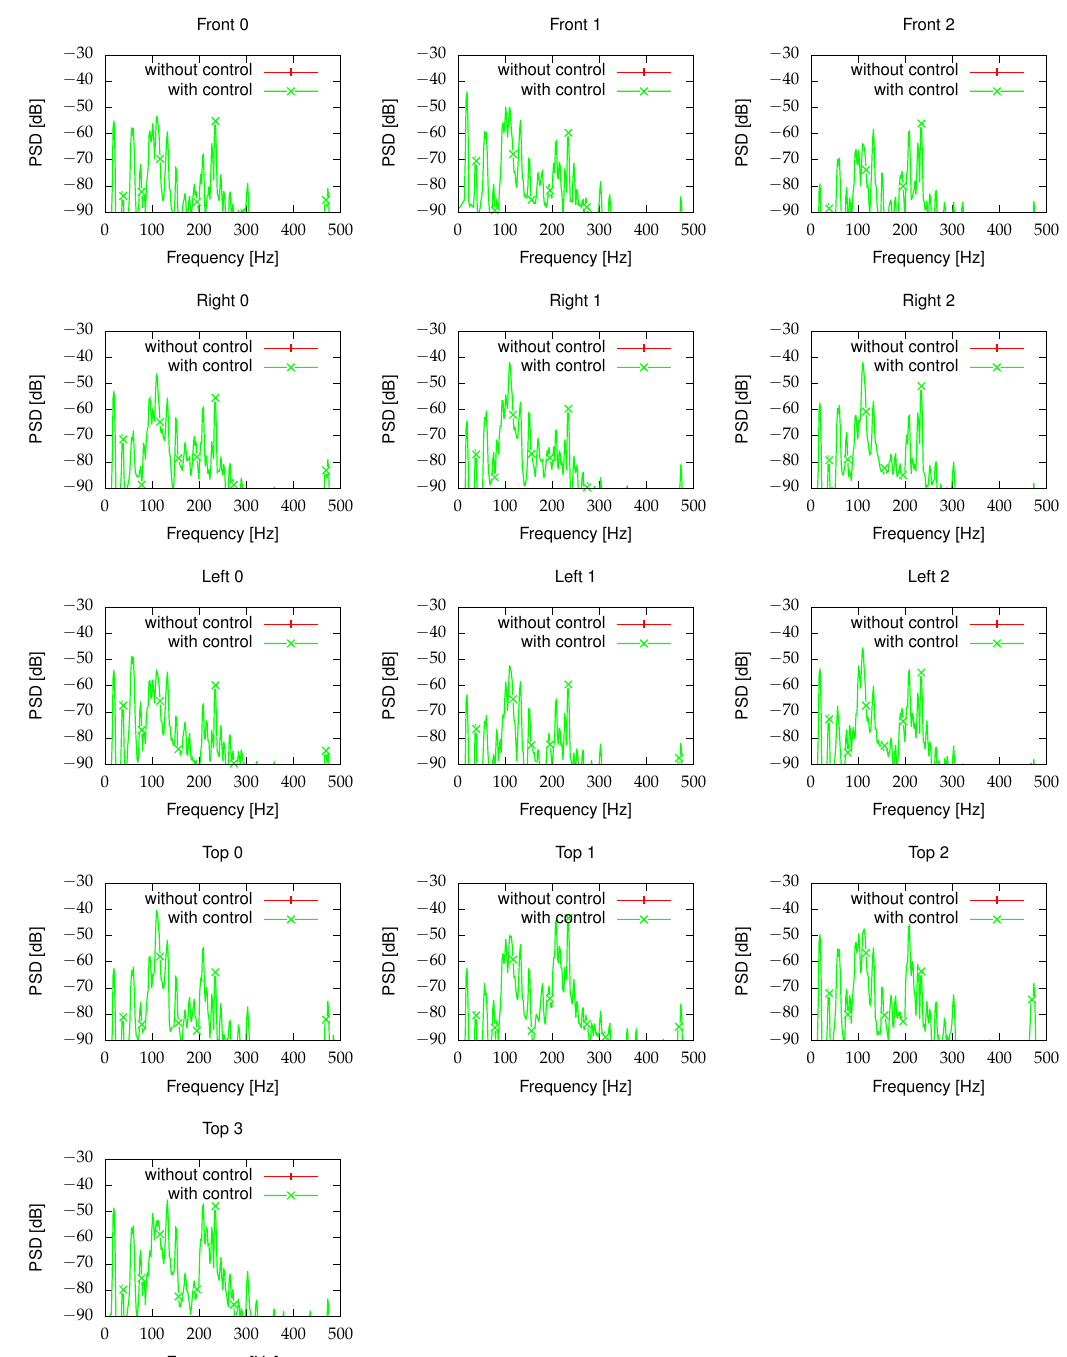
Figure 9. Power spectral densities of control signals for spinning at 1200 rpm.